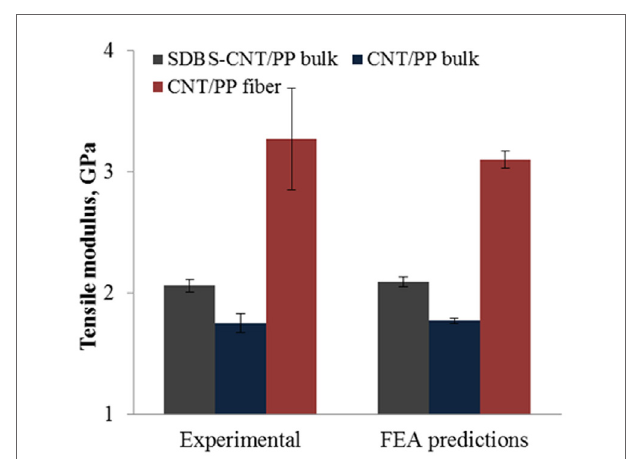
FigUre 11 | Fea predictions for tensile modulus of cnT/PP bulk composites (both modified and non-modified cnT) and cnT/PP fiber